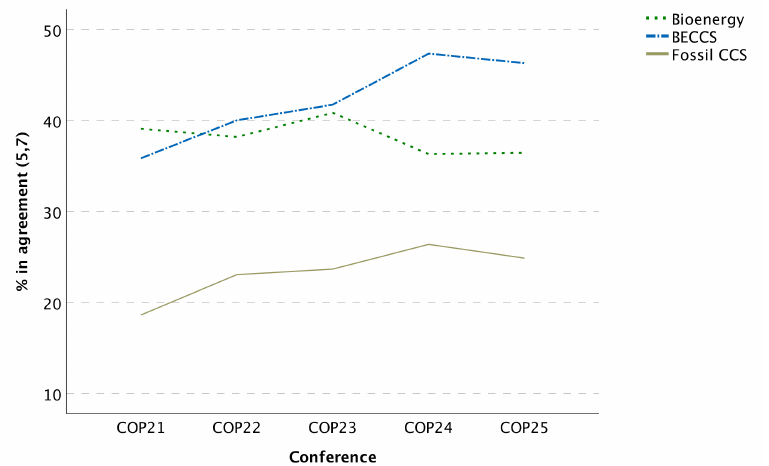
Figure 3. Line graph comparing responses of 5 (agree slightly) or above for bioenergy, BECCS, and fossil CCS. The graph indicates more positive attitudes over time for BECCS and fossil CCS and more negative attitudes for bioenergy without